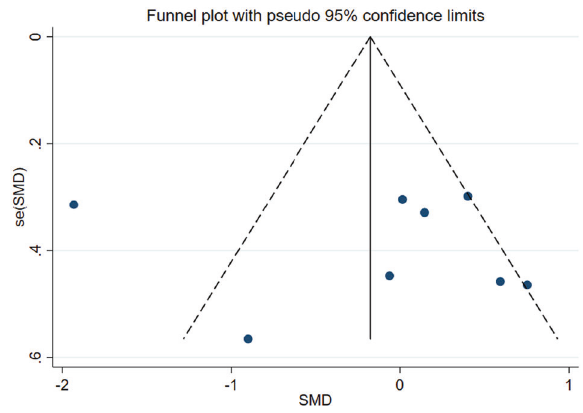
Fig. 6 Funnel plot of HAMD scale